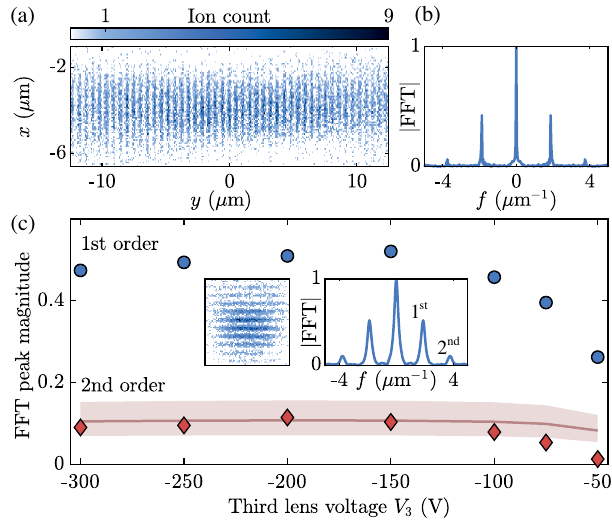
FIG. 5. Depth of field and resolution. (a) Imaging result for an increased depth of field limited only by the cloud size ( 1 =e diameter of 70 μ m). (b) Absolute value of the FFT corresponding to the integrated lattice profile shown in panel (a). (c) Magnitudes of the first- and second-order FFT peaks (here, as a function of V 3 and for a tightly confined ionization region) serving as a qualitative measure of the resolution. All experimental error bars (see Appendix F) are smaller than the marker size. The insets show the experimental data for V 3 ¼ − 150 V. The solid line and the shaded area show the theoretical prediction for the upper bound of the second-order peak amplitude for a resolution of 200 (cid:2) 20 nm. Experimental circumstances are detailed in the main